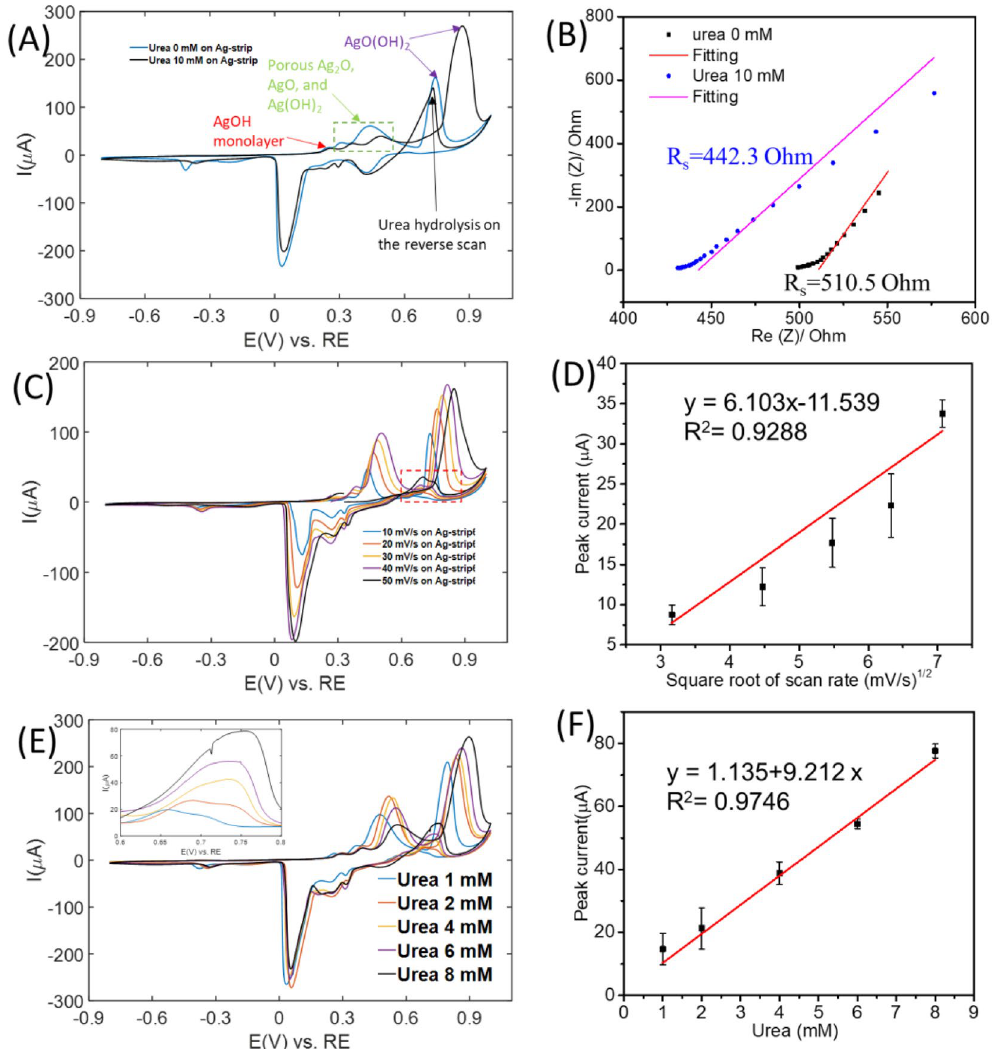
Figure 5. Sensing performance of the AgNP-coated test strip for urea detection. ( A ) CV response and ( B ) EIS of AgNP-coated glucose test strip in the absence and presence of urea; ( C ) CV response of AgNP-coated glucose test strip in the presence of urea at different scan rates (10–50 mV/s), and ( D ) corresponding calibration plot of peak current vs. square root of scan rates. ( E ) CV response of AgNP-coated glucose test strip in the presence of urea at different concentrations (1–8 mM) and ( F ) corresponding calibration plot of peak current vs. urea